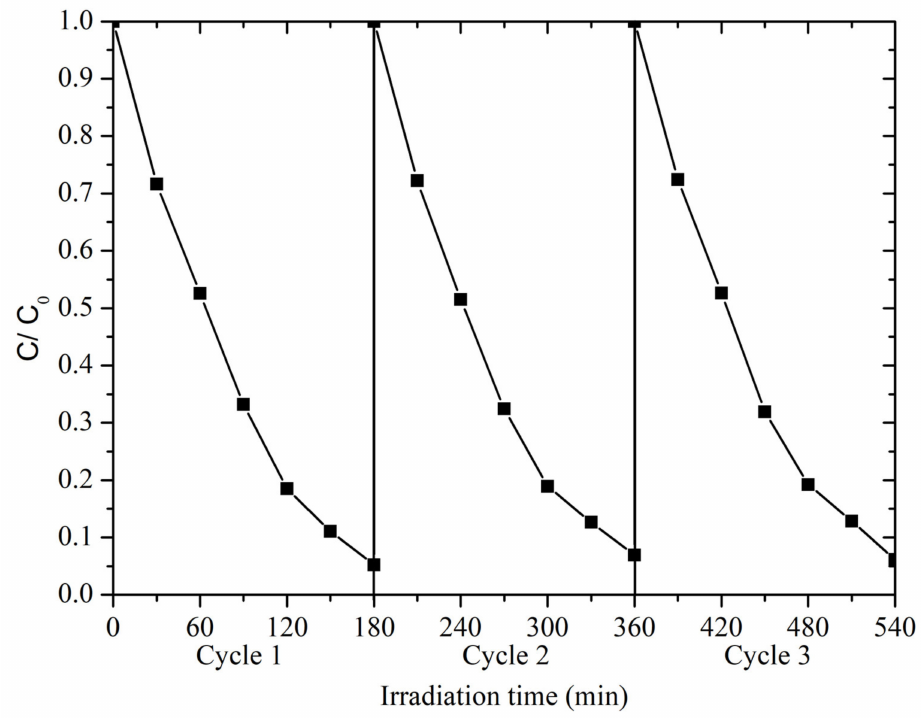
Figure 10. Reusability test of Fe/Mt/TiO 2 synthesized at 70 ◦ C for phenol